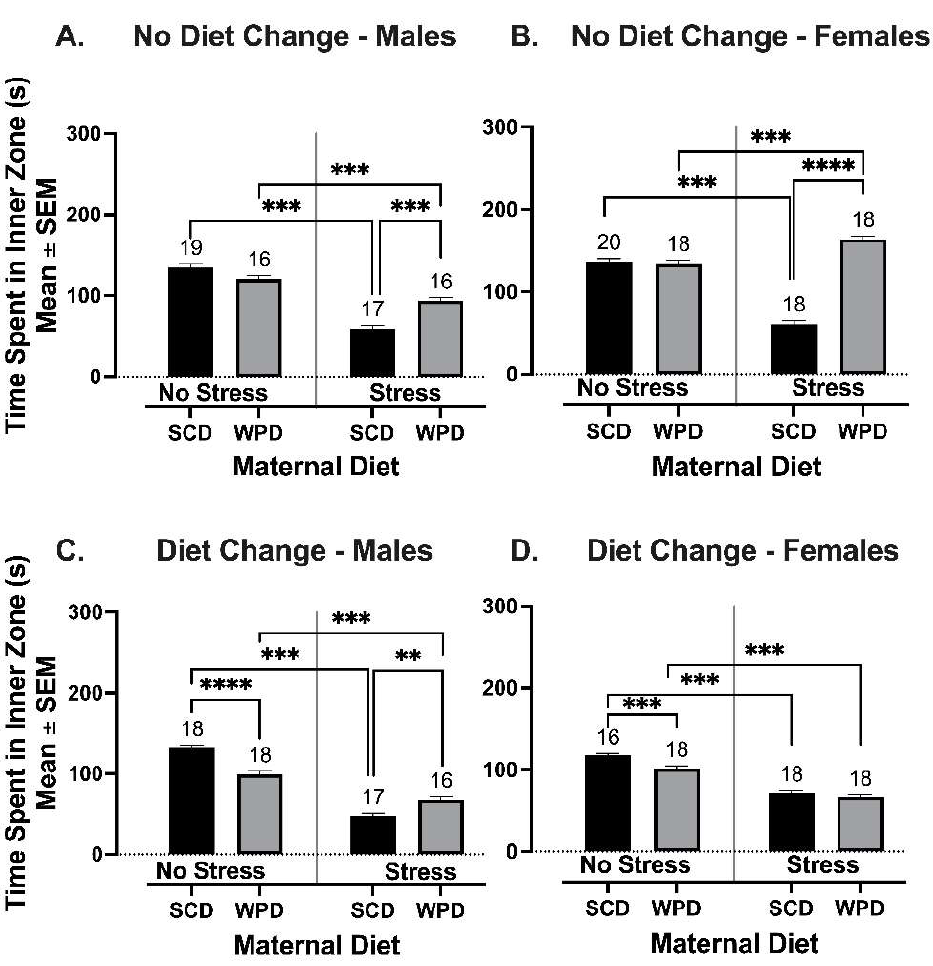
Figure 6. Time spent in the inner zone of the OF for ( A ) males whose diets remained consistent at weaning; ( B ) females whose diets remained consistent at weaning; ( C ) males whose diets were switched at weaning; and ( D ) females whose diets were switched at weaning. Group n ’s located above bars. WPD = western pattern diet. SCD = standard chow diet. ** p < 0.01, *** p < 0.001; **** p < 0.0001.